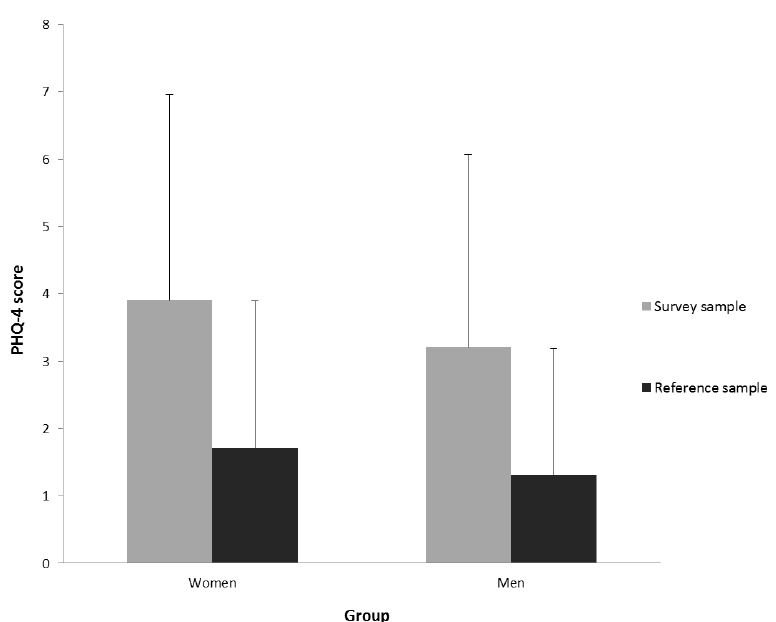
Figure 1. Anxiety and Depression (Patient Health Questionnaire (PHQ-4)): Means and standard deviation of PHQ-4 score for depression and anxiety for women and men in the reference and survey sample.